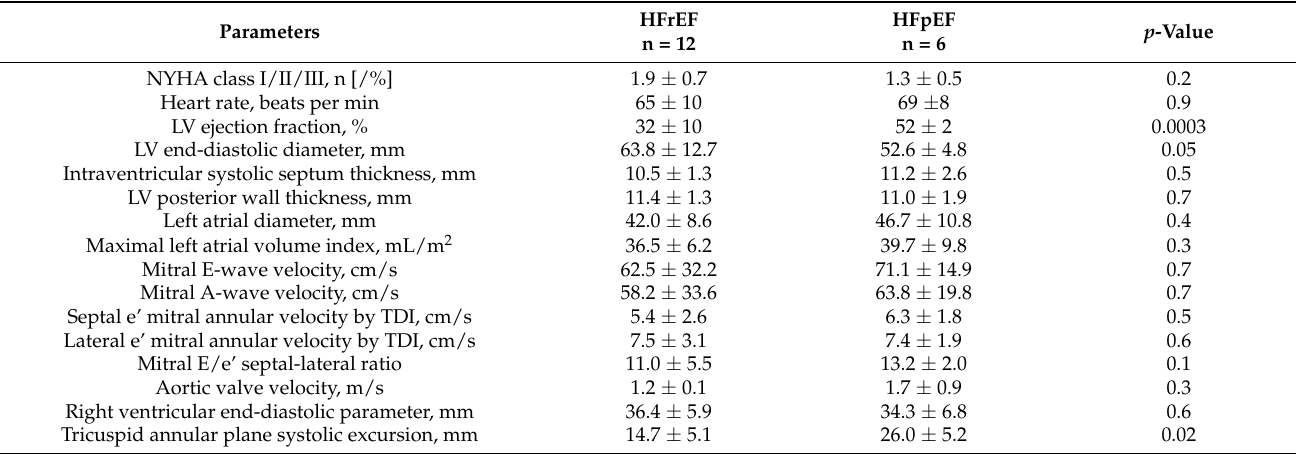
Table 2. Baseline cardiac characteristics of patient groups.